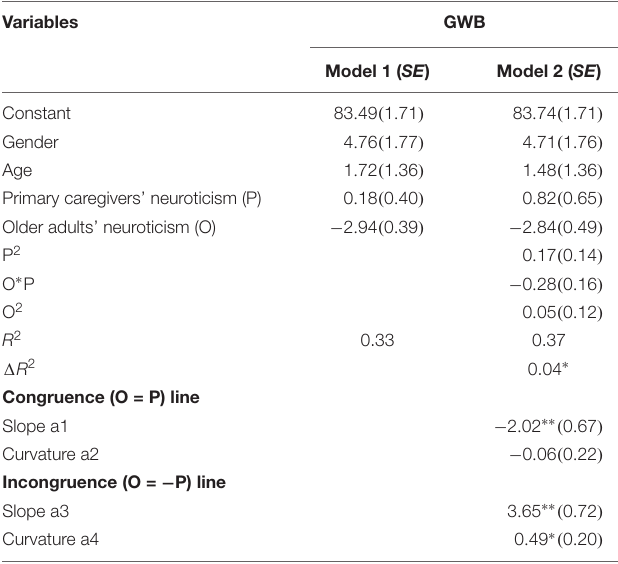
TABLE 5 | Cross-level polynomial regressions of PR and GWB on neuroticism congruence/incongruence ( n =